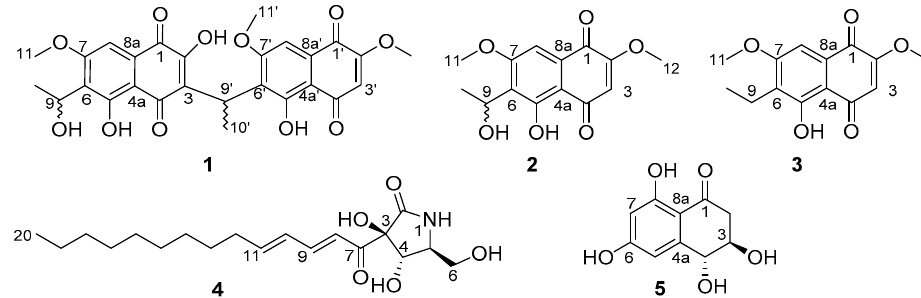
Figure 1. Structures of isolated compounds 1 – 5 .